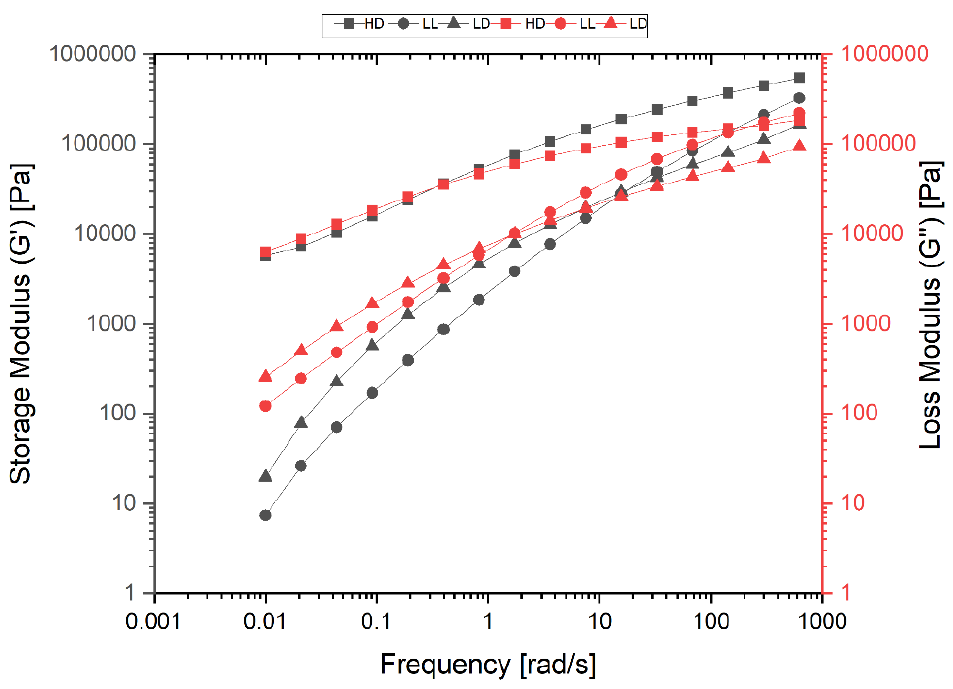
Figure 9. Diagram of storage modulus G’ and loss modulus G” in terms of angular frequency ω for HDPE (HD), LLDPE (LL), and LDPE (LD).